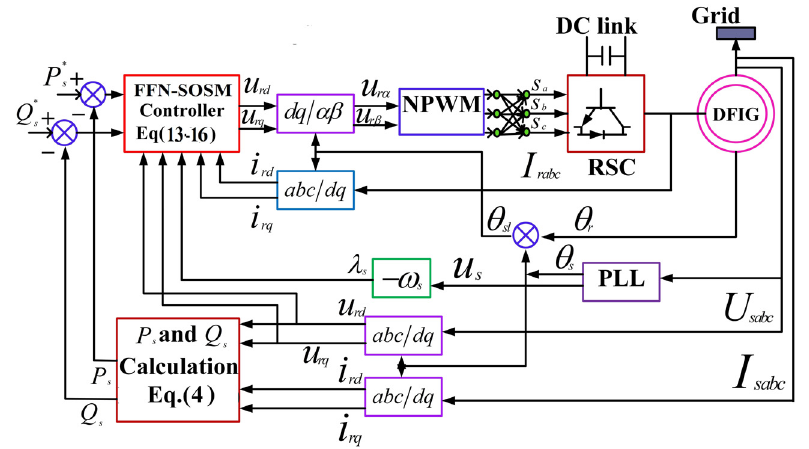
Figure 5: Proposed controller diagram of FFN - SOSM.